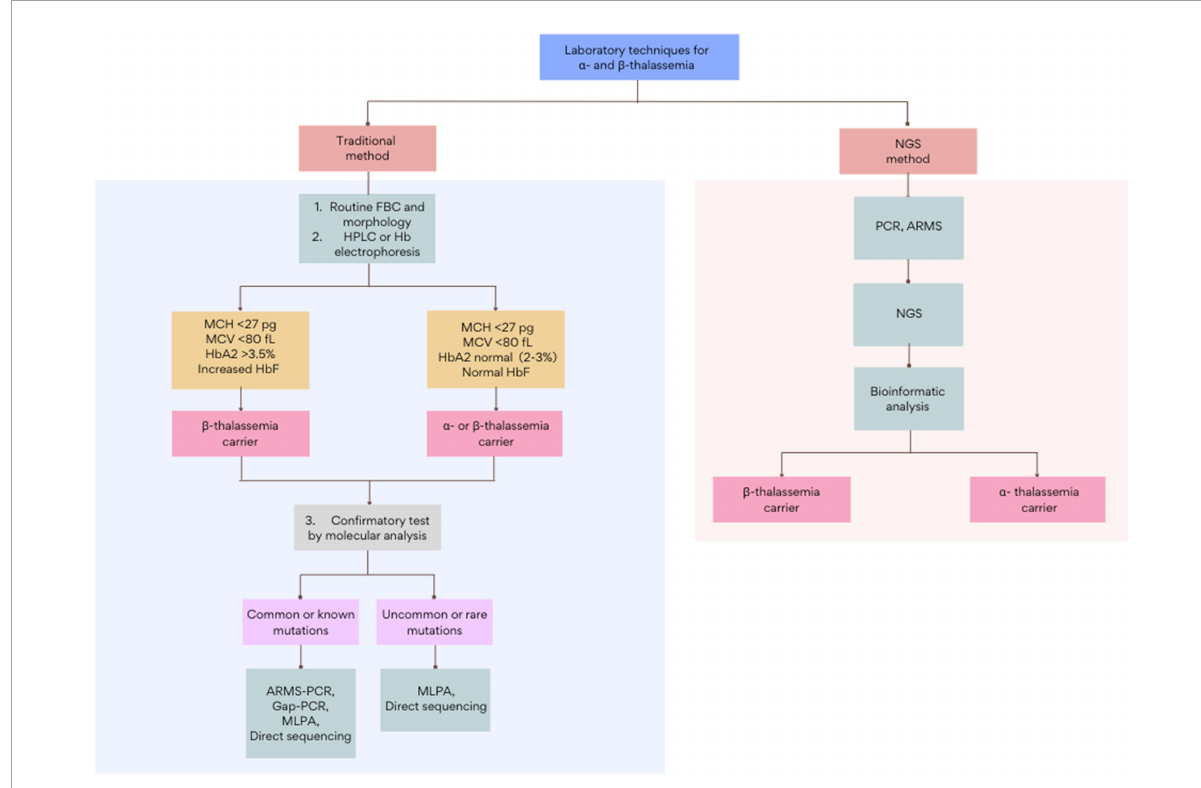
FIGURE1 The general workflow for the screening and diagnosis of α - and β -thalassemia using traditional and NGS-based methods. Figure adapted from Chen et al. (28) and Nigam et al. (55). FBC, full blood count; HPLC, high-performance liquid chromatography; ARMS, amplification refractory multiple sequencing; PCR, polymerase chain reaction; MLPA, multiplex ligation-dependent probe